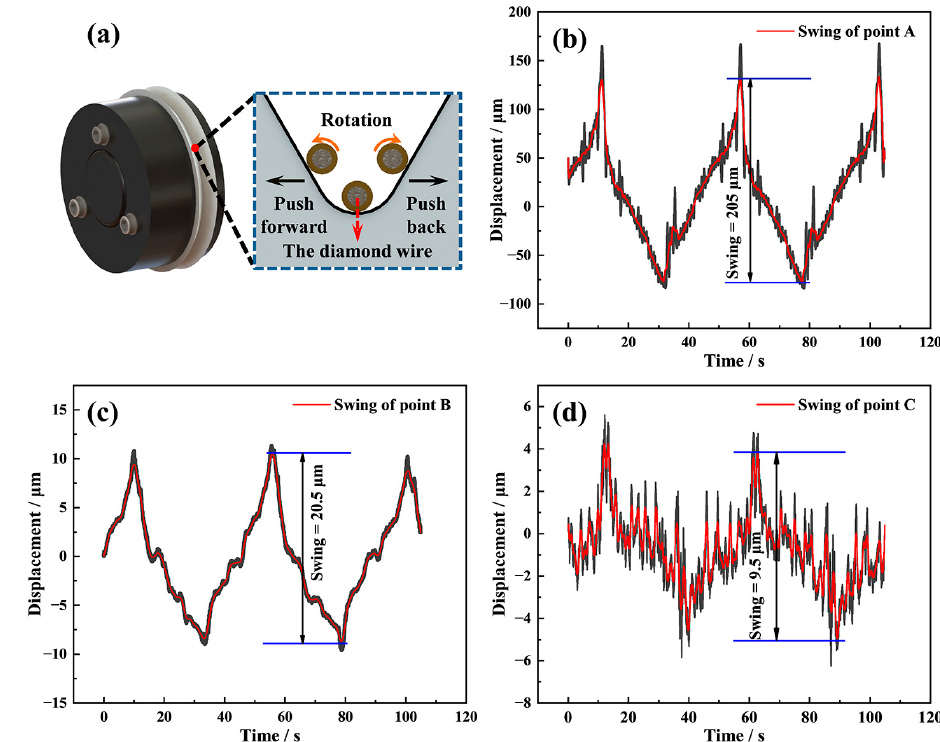
Figure 6. ( a ) Rotation of the diamond wire in the groove bottom; ( b ) the wire swing of point A; ( c ) the wire swing of point B; ( d ) the wire swing of point C. wire swing of point B; ( d ) the wire swing of point